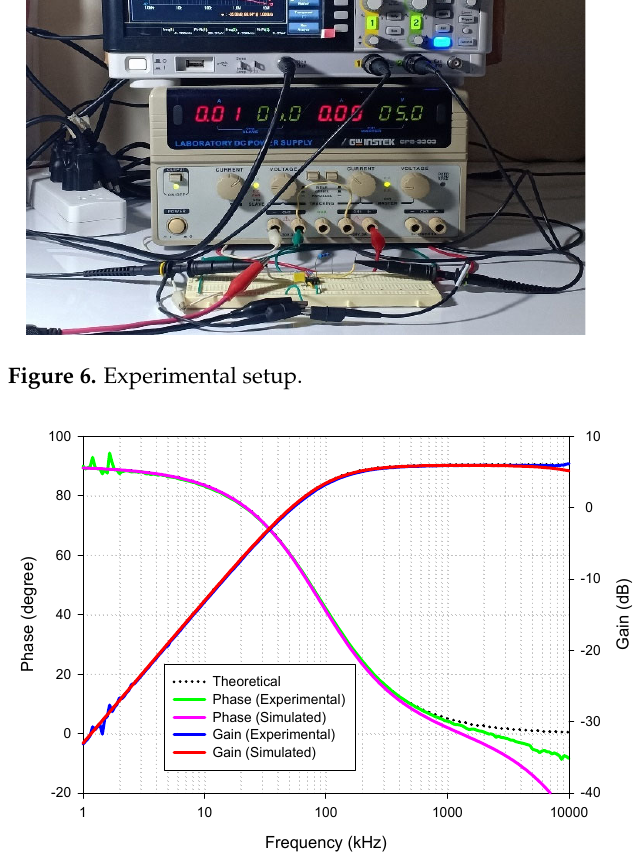
Figure 7. Frequency gain and phase response of HP.